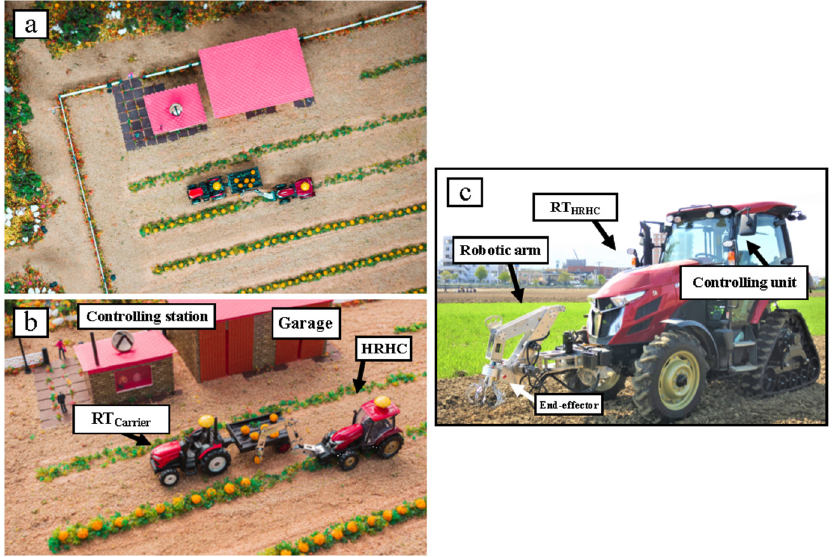
Figure 1. The HRHC system ( a ) required systems for operation, ( b ) components for operation, and ( c ) detailed components.